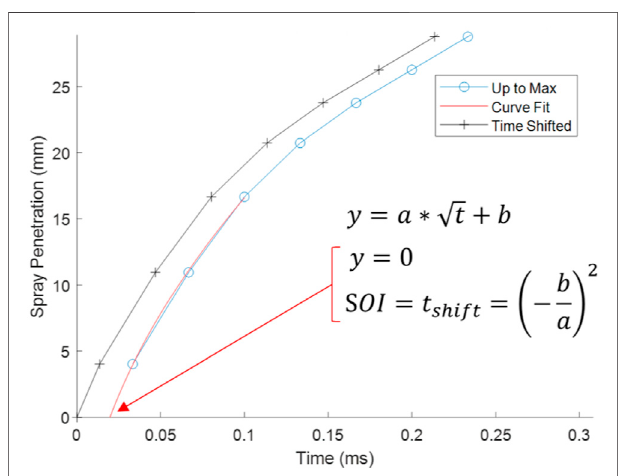
FIGURE 9 | Averaging windows used for determining quasi-steady- state dispersion angle.